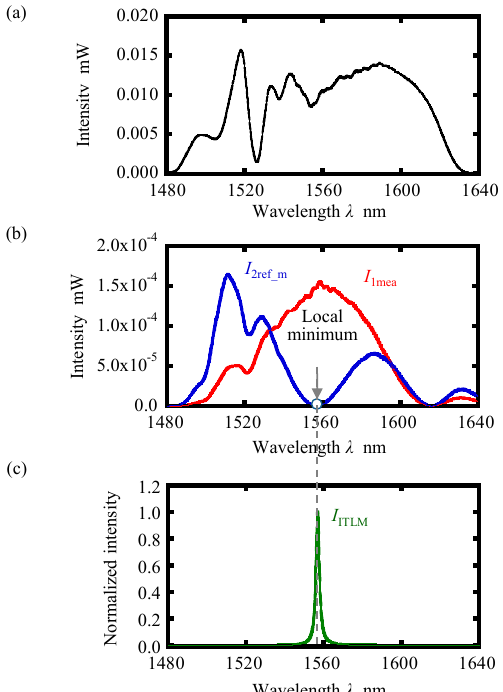
Figure 8. Schematic of the wavelength-to-displacement encoding in the proposed off-axis differential chromatic confocal probe system. ( a ) A spectrum of the mode-locked femtosecond laser employed in this paper; ( b ) chromatic confocal outputs obtained by the detector units; ( c ) the normalized chromatic confocal output obtained through the arithmetic operation with I 1mea and I 2ref_m .